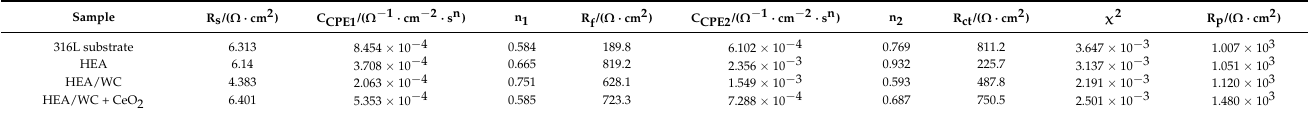
Table 6. The fitting results of components in the equivalent